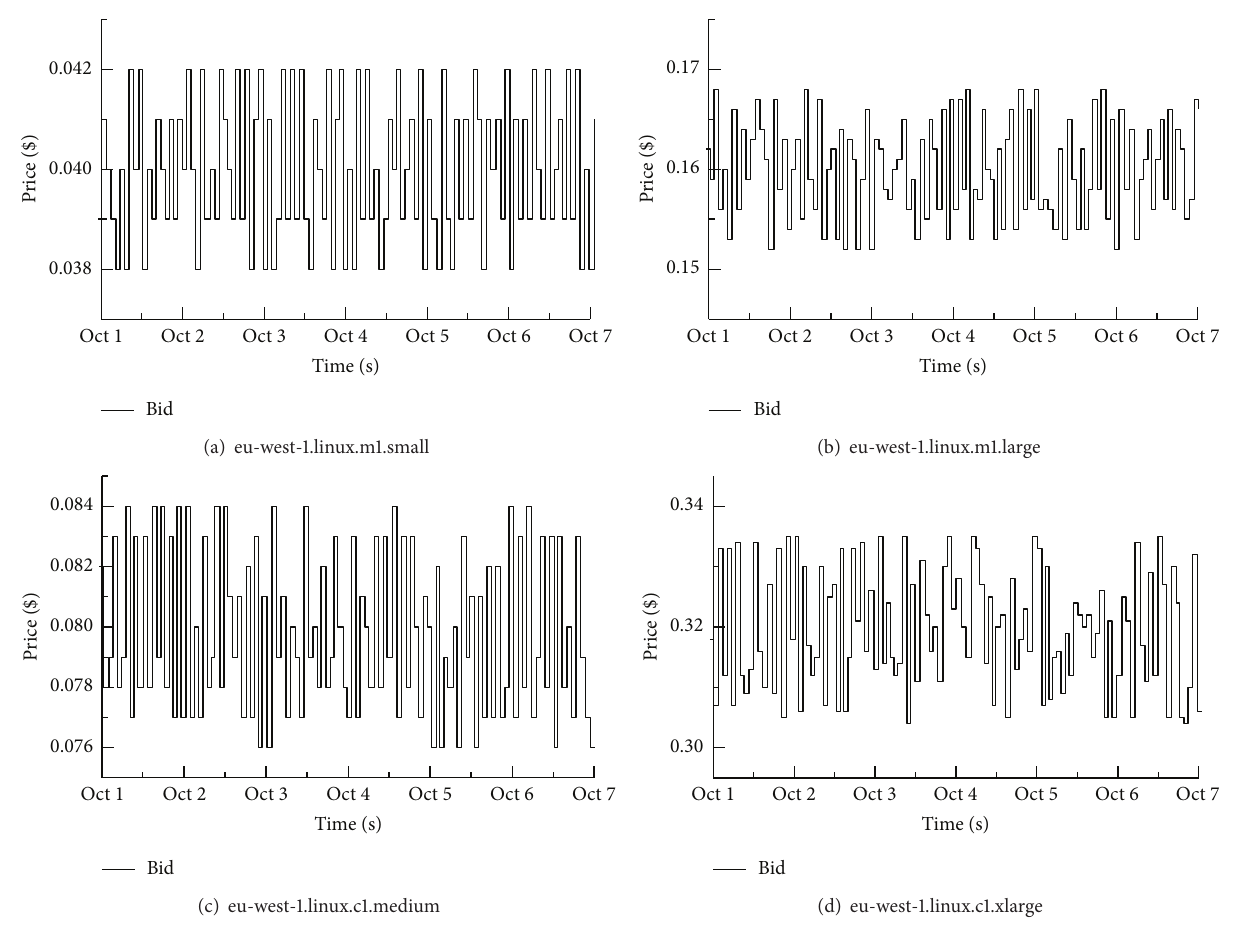
Figure 1: Price history of EC2’s spot